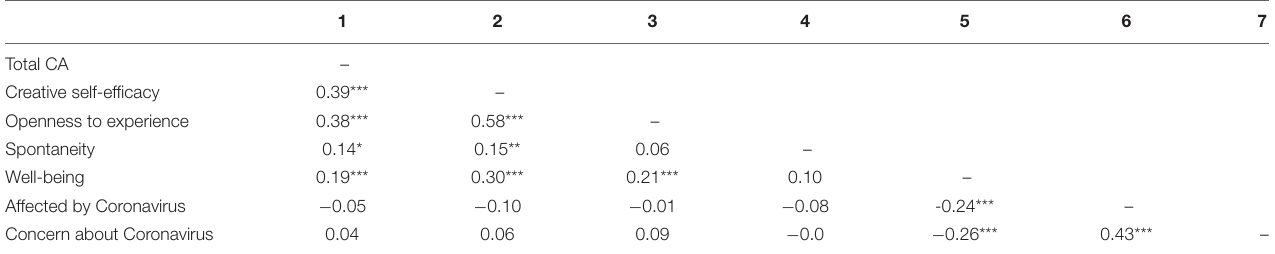
TABLE 3 | Pearson’s correlations for all variables.